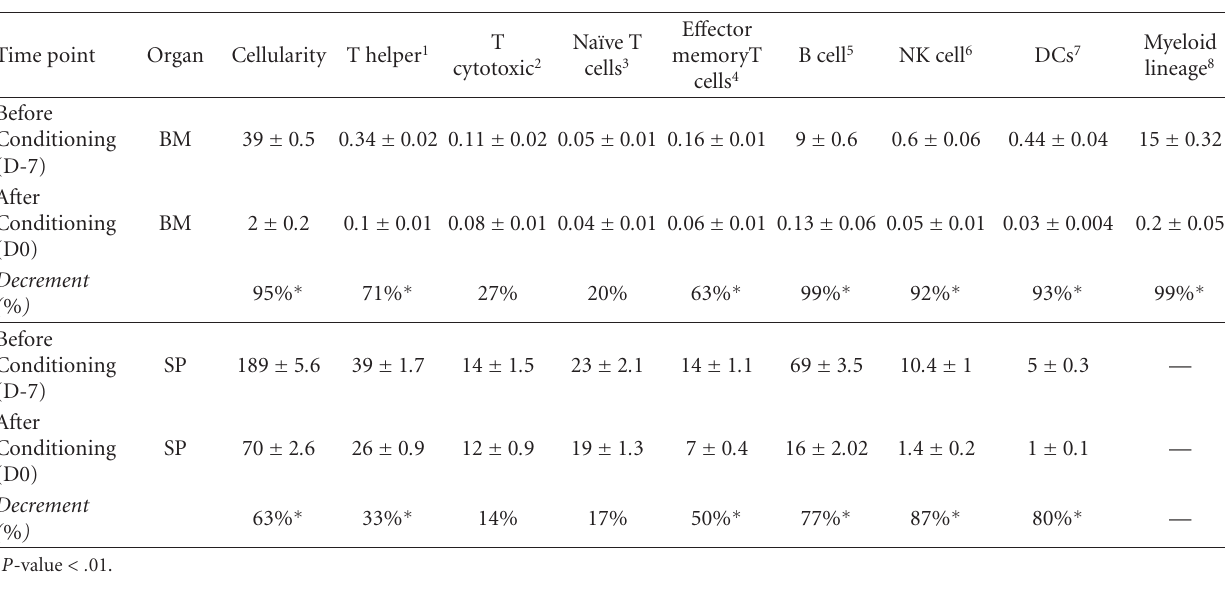
Table 1: E ff ect of conditioning on the di ff erent immune cell of bone marrow and spleen. Female BALB/c mice were treated with busulfan (80mg/kg) followed by cyclophosphamide (200mg/kg). Bone marrow and spleen cellularity plus immune cell phenotype were evaluated using flowcytometry before and after conditioning. Total and individual immune cells in the bone marrow are more sensitive to the conditioning compare to the spleen cells. 1 CD3+CD4+, 2 CD3+CD8+, 3 CD44 low CD62 high , 4 CD44 high CD62 low , 5 CD19+, 6 DX5+, 7 CD11c+, and 8 CD11b+. ( ∗ P < . 05)